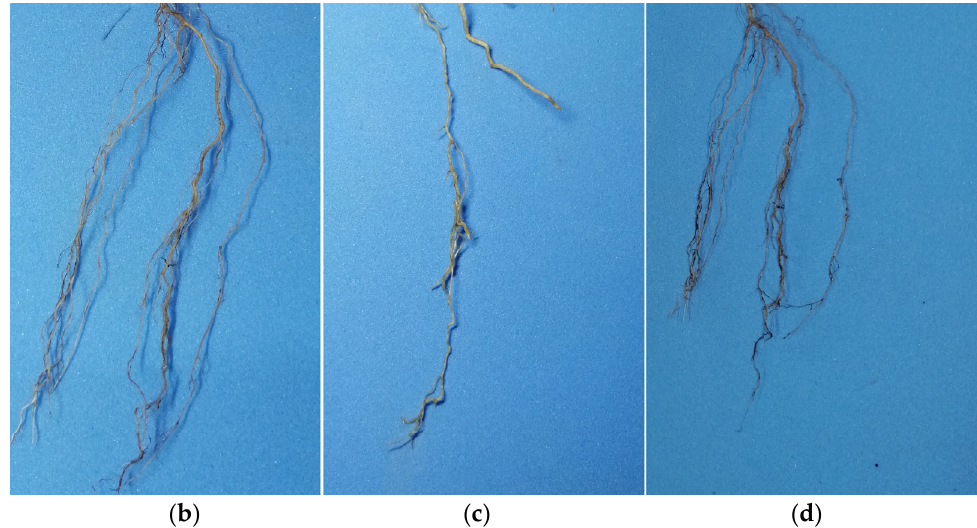
Figure 3. Effect of three concentrations of soil boron availability, deficient ( a , b ), adequate ( a – c ), and toxic ( a – d ) (0.04, 1.10, 3.75 mg kg − 1 ), respectively, on the root of cherry trees.